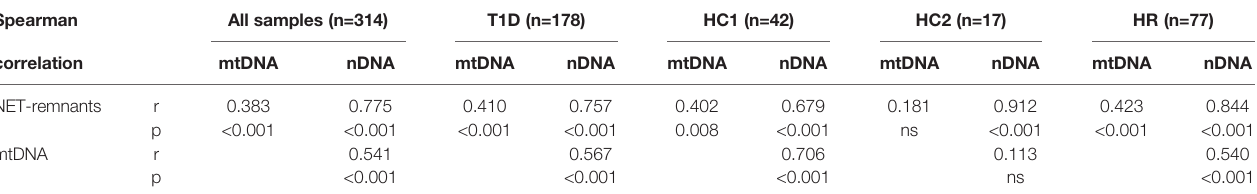
TABLE 2 | Correlations between NETs, mtDNA and nDNA for all samples analysed in this study (cohort 1-3) at all time points and for T1D, healthy controls in cohort 1 (HC1), healthy controls in cohort 3 (HC3) and high-risk individuals (HR) separately. Spearman